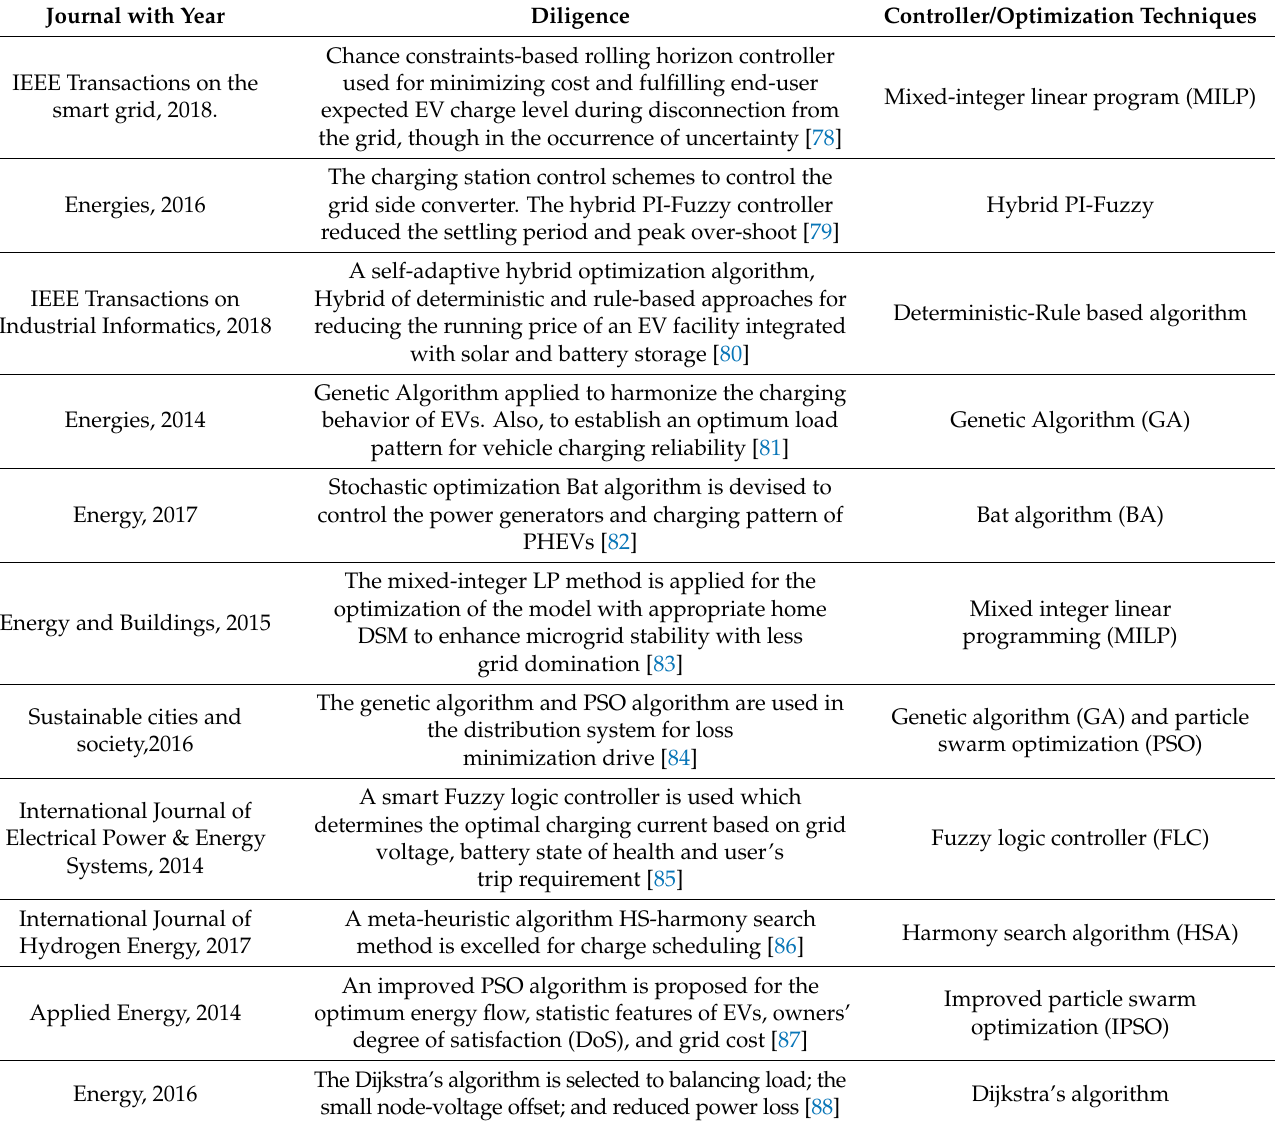
Table 4. A list of various optimization algorithms used for various objective functions across